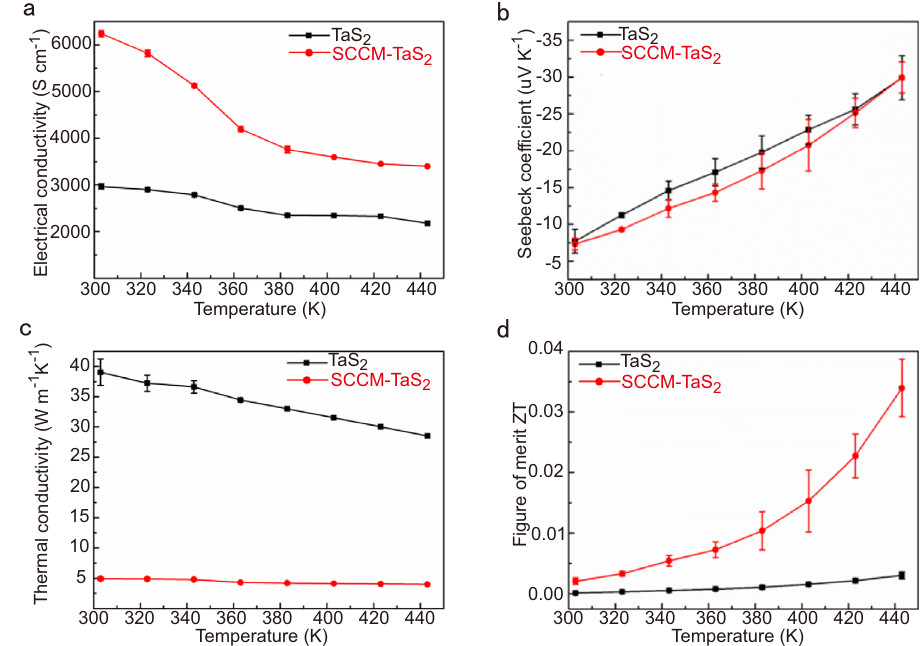
Fig. 4 | Thermoelectric properties of the pristine TaS 2 crystals and SCCM-TaS 2 hybrid structure. a Electrical conductivity. b Seebeck coef fi cient. c In-plane ther- malconductivity. d In-planethermoelectric fi gureofmerit,ZT.Alloftheerrorbars